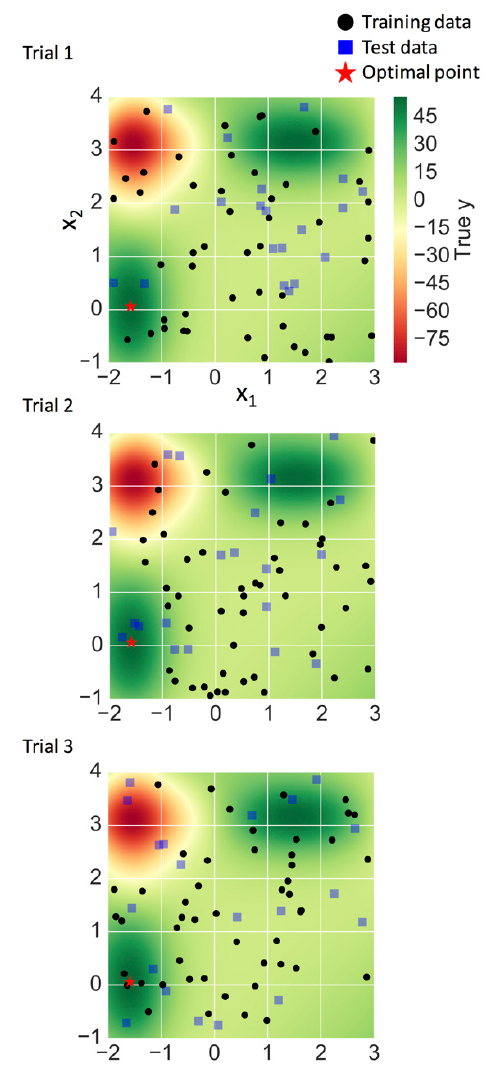
Figure 3. Simulation data sets. In three independent trials, simulation data sets were generated. For each trial, training (black dots) and test (blue squares) data are shown with true y values produced by the bird function f ( x